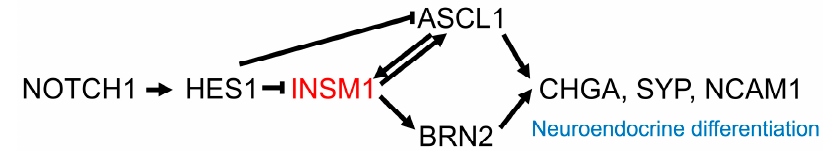
Figure 1. Schematic of the complex pathways of neuroendocrine differentiation (blue) in lung tumors. INSM1 (red) is inactivated by HES1 and promotes the expression of the three neuroendocrine molecules (CHGA, SYP, and NCAM1) via activation of the transcription factors, ASCL1, and BRN2. INSM1 and ASCL1 activate each other.